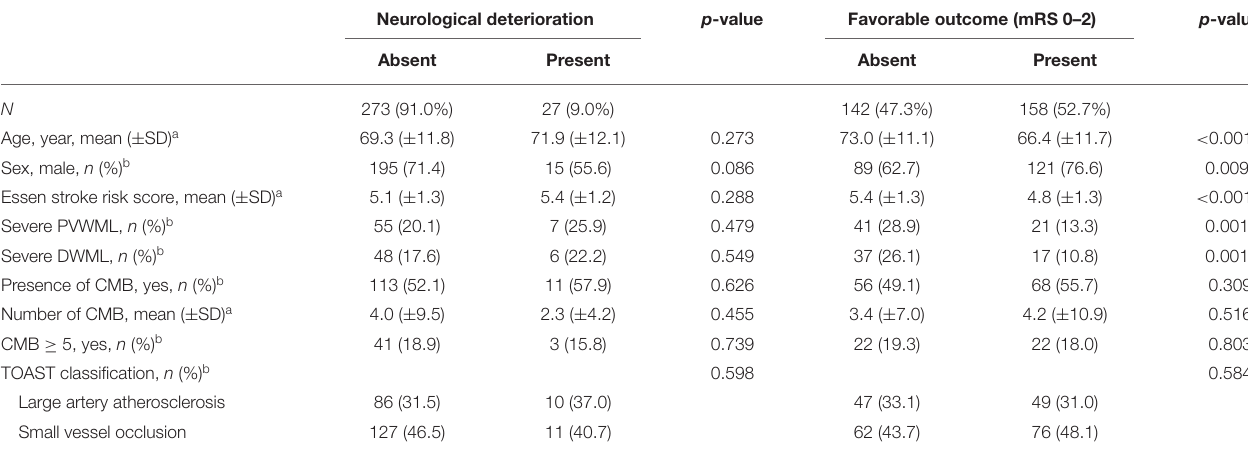
TABLE 5 | Risk factors and predictors for neurological deterioration and favorable outcome in stroke patients with aspirin treatment failure. Neurological deterioration